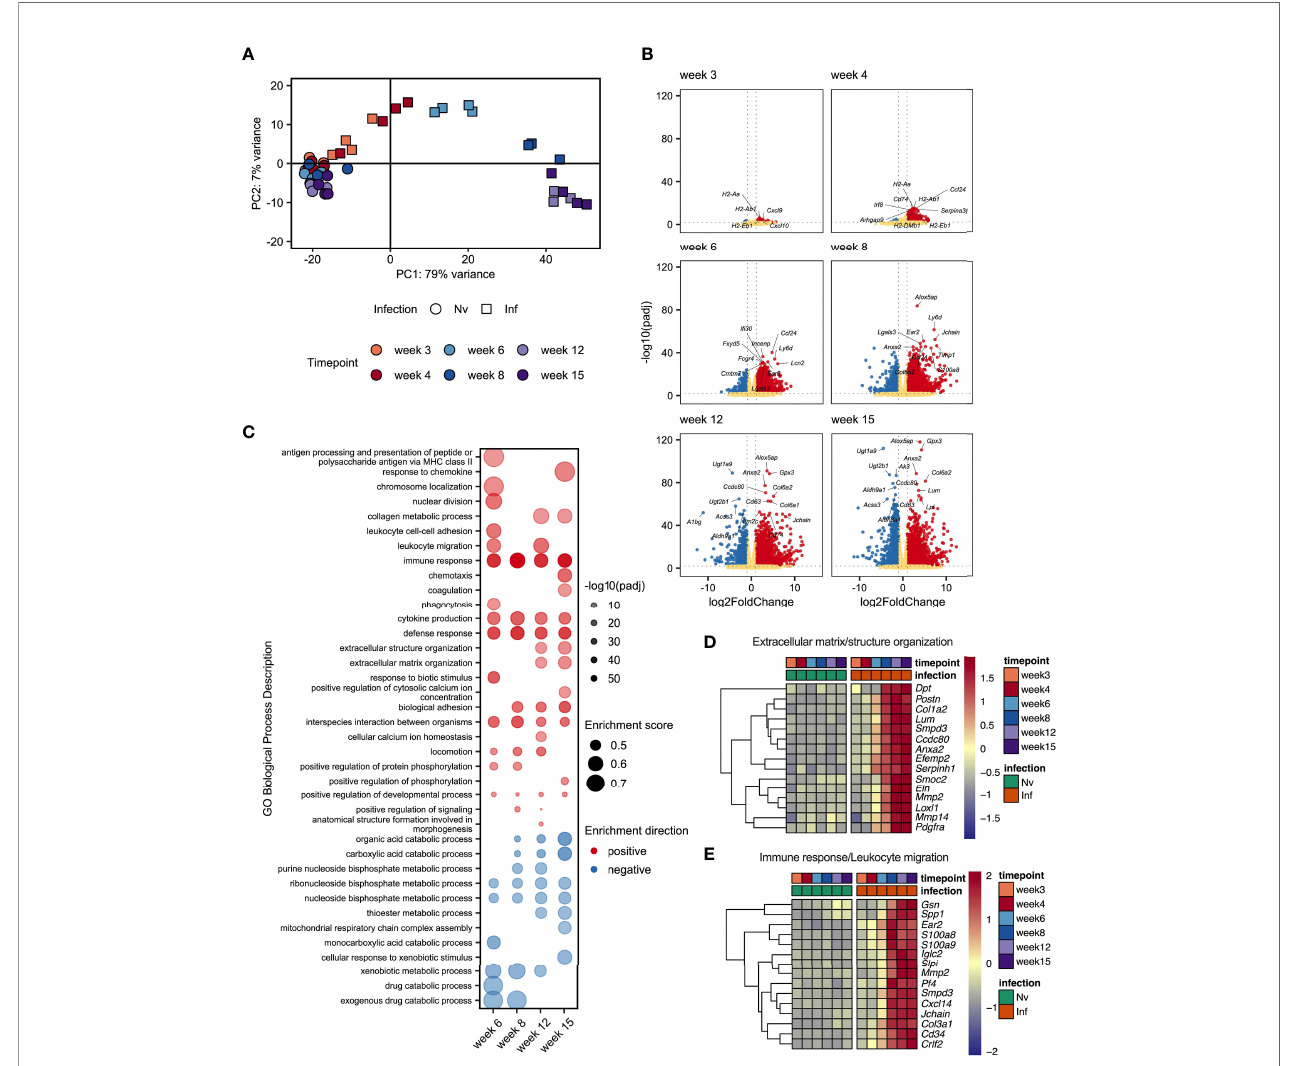
FIGURE 4 | Schistosome egg deposition dramatically alters the liver transcriptome. Livers from schistosome infected mice (Inf) or matched naïve controls (Nv) were harvested at 3, 4, 6, 8, 12 and 15 wks post infection (40 cercariae infection, n=3-4 per timepoint). RNA was isolated from the liver tissue and transcriptionally pro fi led by RNAseq. (A) Principal components analysis of total read counts. Points represent individual replicates. Point shape indicates group, Nv ( ○ ) Inf ( ◻ ), and colour indicates timepoint. (B) Volcano plots of differentially expressed protein-coding genes in Inf vs Nv mice at each time point. Genes were considered signi fi cantly differentially expressed in Inf mice when the adjusted p value (padj) was < 0.01 and the log2FoldChange was > 1. Red dots indicate genes signi fi cantly up-regulated in Inf mice, blue dots indicate genes signi fi cantly down-regulated in Inf mice, yellow dots represent genes not signi fi cantly differentially expressed between Inf and Nv mice. (C) Gene set enrichment (GSE) analysis for Inf mice from wk 6 to wk 12 using GO Biological Process terms based on genes with a padj < 0.01 vs Nv mice. Points represent the enrichment score for a given GO term at each time point. Size of point indicates the enrichment score. Opacity of point indicates the signi fi cance value for that enrichment score expressed as -log10(padj). Point colour indicates whether a given GO term was positively (red) or negatively (blue) enriched. Blank spaces indicate that GO term was not signi fi cantly enriched at that timepoint. GO terms were considered signi fi cantly enriched if padj < 0.01. Heatmaps representing the mean expression of top 15 most signi fi cantly differentially expressed genes identi fi ed in speci fi c GO terms: (D) “ extracellular matrix structure ” and “ extracellular matrix organisation ” and (E) “ Immune response ” , and “ Leukocyte migration ” . All genes presented by heatmap had a p value < 0.01. Differential expression analysis was performed using DESeq2, GSE analysis was performed using clusterPro fi